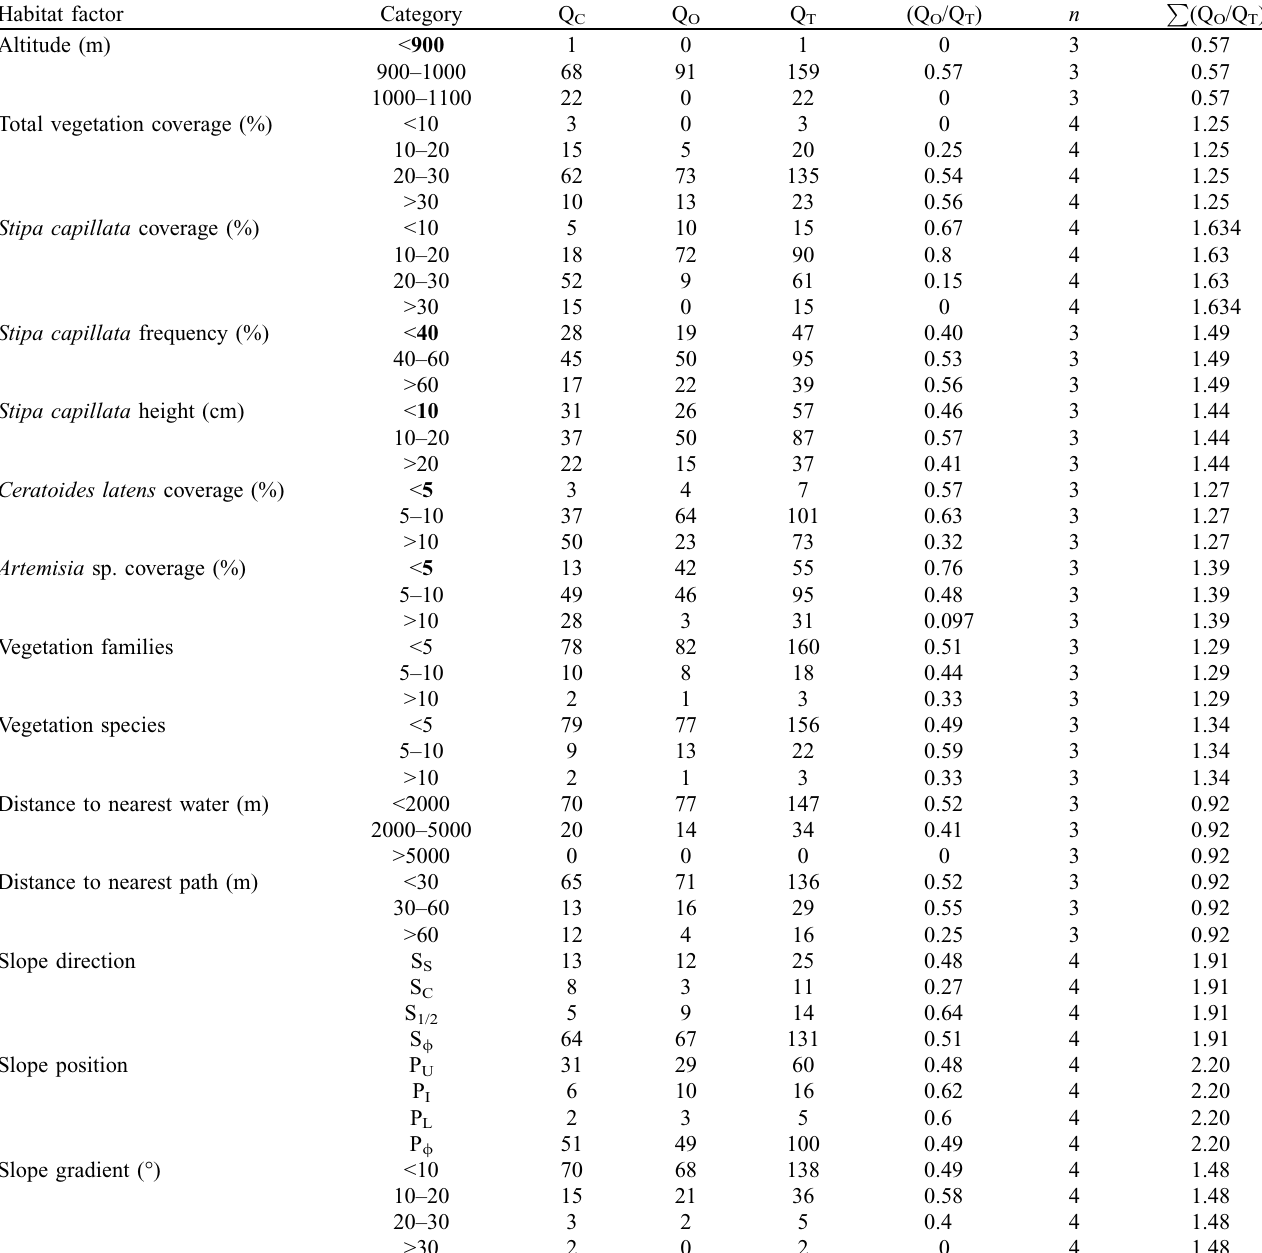
Table 1. Frequency distribution of habitat factors in oviposition site selection by G . pecorum in different habitats in KNR. Habitat factor Category